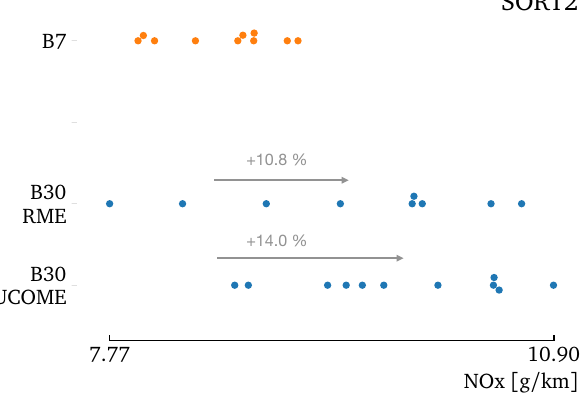
Figure 8. The easy urban SORT 2 (less aggressive dynamics) test runs indicate higher NOx emissions for B30 RME and B30 UCOME compared to B7 with an average increase varying between 10% and 14%.